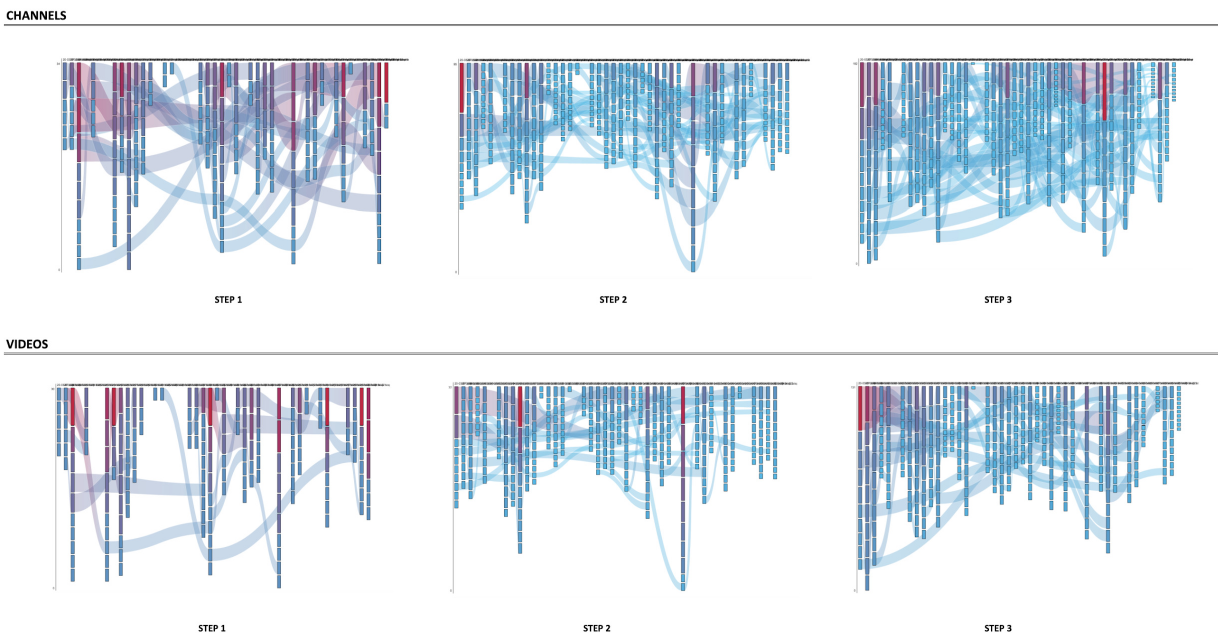
Figure 3. RankFlow visualization of “feminism” for the top 10 most recommended channels at step 1, step 2, and step 3 (top), and for the top 10 most recommended videos at step 1, step 2, and step 3 (bottom).